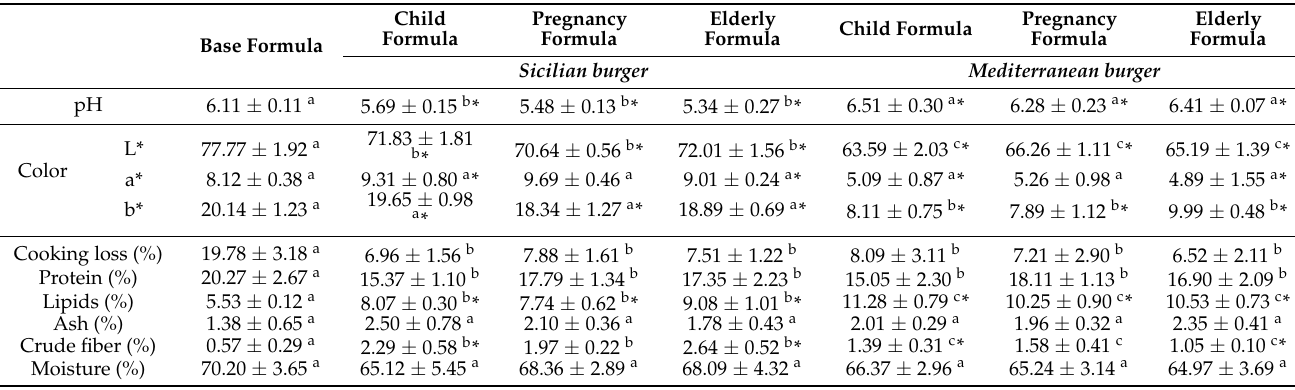
For control and treated burgers: different superscript letters in the same row indicate significantly different values for a given parameter ( p < 0.05 by post hoc Tukey’s honestly significant difference [HSD] test); same superscript letters in the same row indicate not significantly different values for a given parameter ( p > 0.05 by post hoc Tukey’s HSD test). For a given fortification formula: * indicates significantly different values between Sicilian and Mediterranean burgers ( p < 0.05 by Student’s t